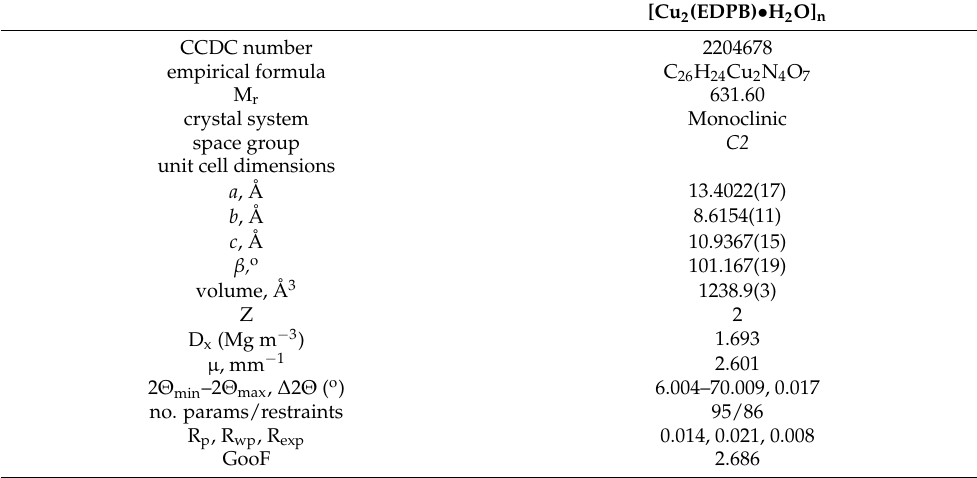
Table 1. Crystal data for [Cu 2 (EDPB) • H 2 O] n